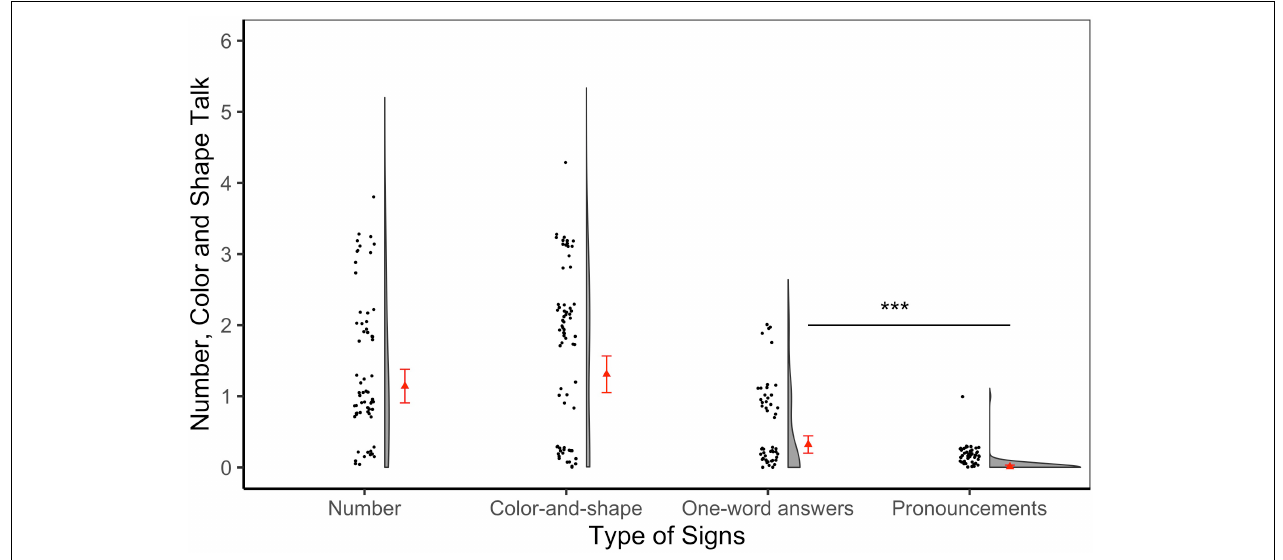
FIGURE 4 | Number, color, and shape talk across the four types of signs. This score ranged from 0 to 6. The red triangle represents the mean and the red whiskers are standard error bars. The black dots represent the individual data points in the distribution and the half-violin plot represents the density of the distribution at different levels of the dependent variable. *** p <